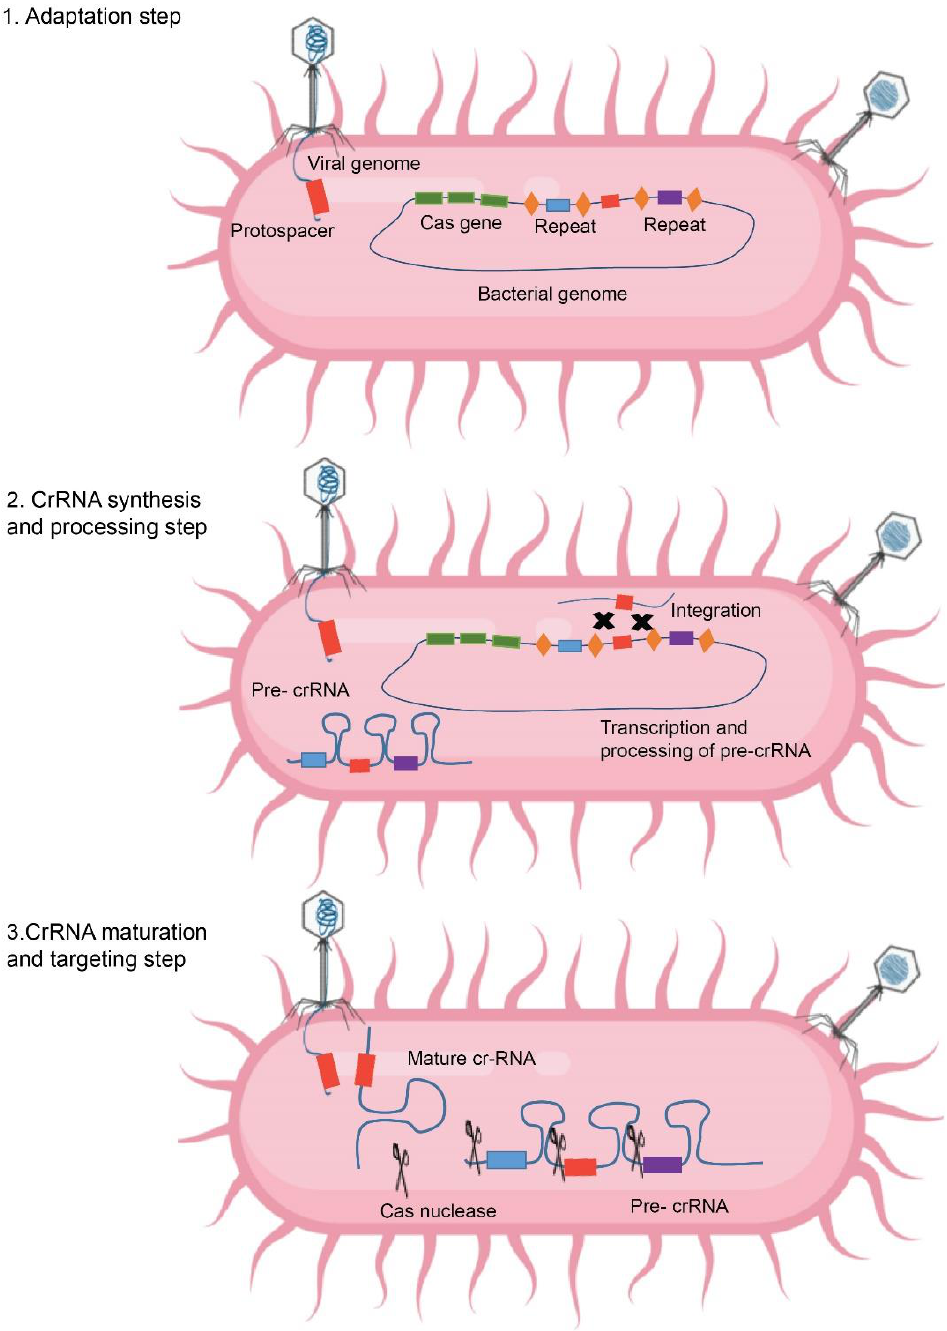
Figure 2. Clustered regularly interspaced short palindromic repeat’s ( CRISPR ’ s) normal operation 1. Adaptation steps: the bacterial cell is invaded by phages, the phage genome enters the host cell, and the protospacer fits into the CRISPR genome. 2. CRISPR RNA (CrRNA) synthesis and pro- cessing step: a single-stranded sequence of repeated and non-repeated (spacer) sequences, named pre-crRNA, is generated via the transcription from the CRISPR gene loci and eventually processed by Cas nuclease and converted to mature crRNA. 3. crRNA maturation and targeting step: pre-crRNA eventually processed by Cas nuclease and converted to mature crRNA, this molecule associated with Cas protein can target and degrade the invading DNA.